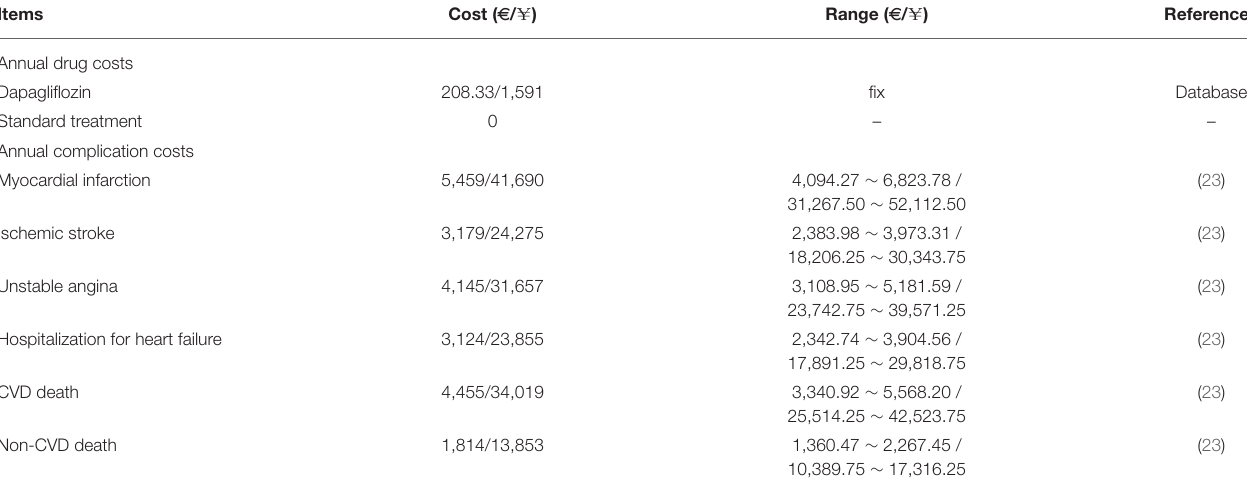
TABLE 2 | Cost inputs.